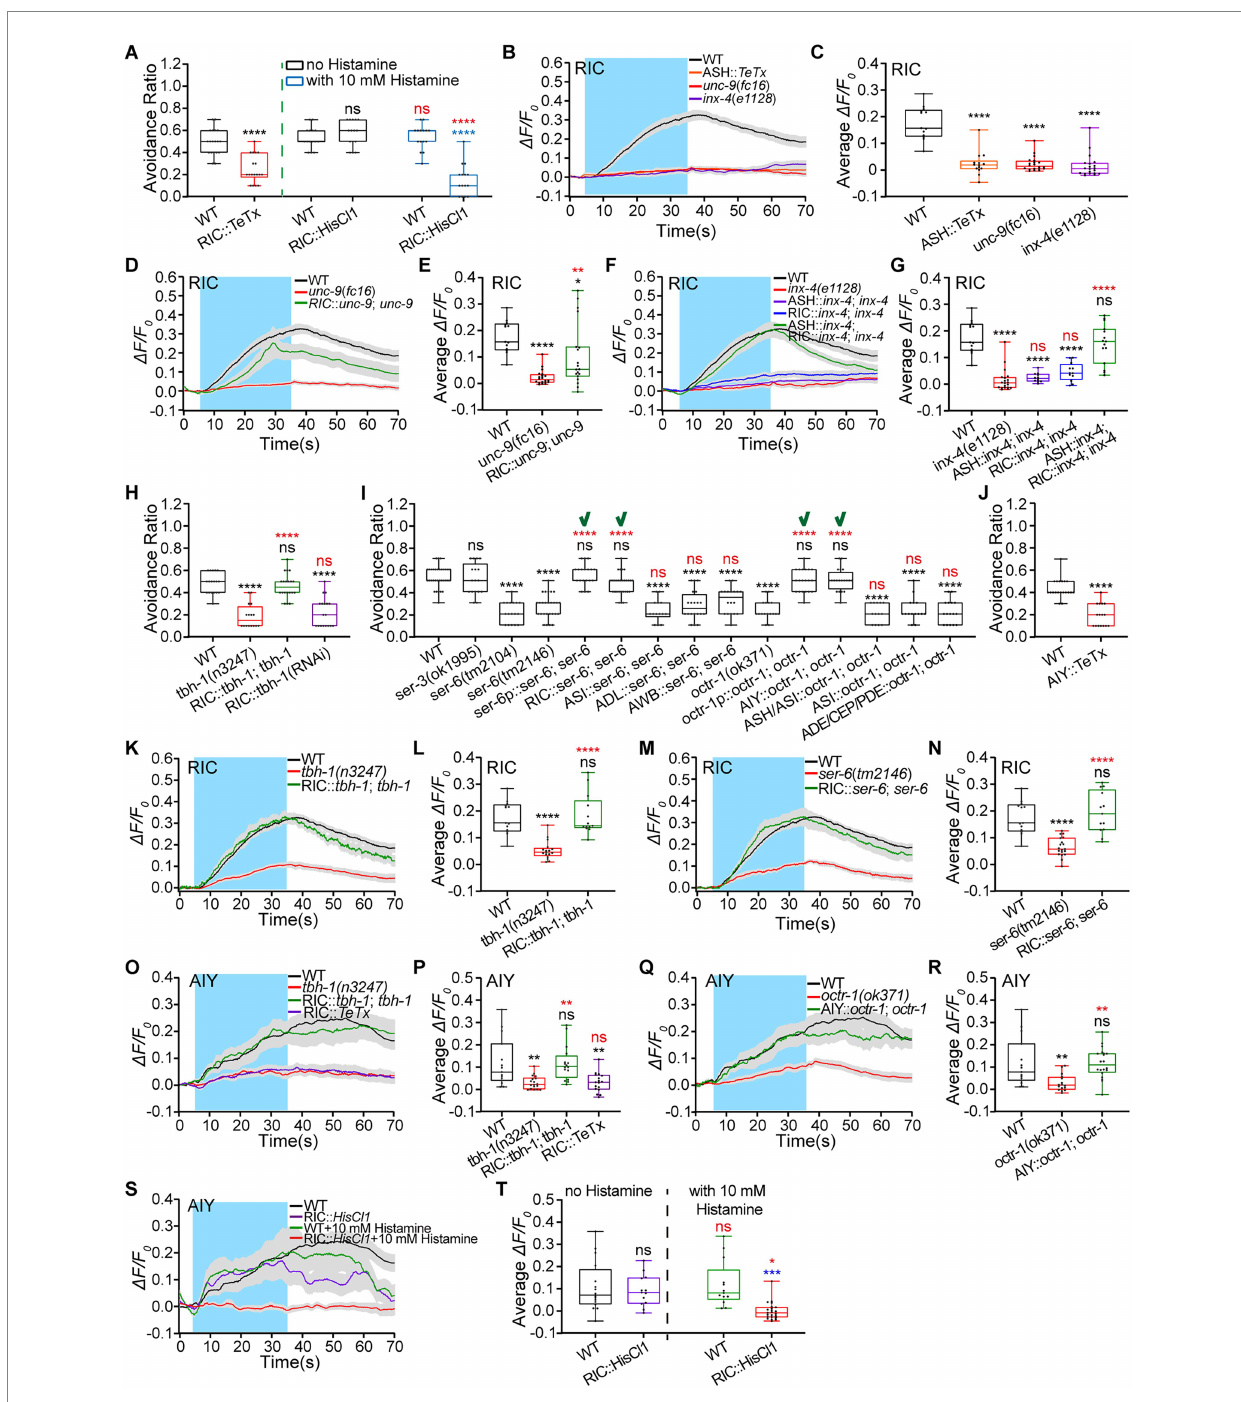
FIGURE 5 Signaling pathways of Octopamine/SER-6 in RIC and octopamine/OCTR-1 in AIY promote animals’ hyperosmotic avoidance. (A) Ratio of avoidance of the hyperosmolality of 0.88 Osm by glycerol/M13 in wild-type (WT) N2 as control and transgenic animals of indicated genotypes. (B–G) The somal calcium signals in RIC interneurons in response to the hyperosmolality of 0.88 Osm in WT, mutant, and transgenic animals of indicated genotypes. (B,D,F) Curves of Ca 2+ transients presented as means (solid traces) ± SEM (gray shading) with cerulean background indicating the application of 0.88 Osm glycerol/M13 solution; (C,E,G) box plots of the average intensity of Ca 2+ signals during stimulation with each dot representing the data from each tested animal or test. (H–J) Ratio of avoidance of the droplet of the hyperosmotic solution in WT N2, mutant, and transgenic animals of indicated genotypes. “ √ ” indicates the success of restoring WT behavior by the genetic rescue indicated. (K–T) The somal calcium signals in RIC (K–N) and AIY (O–T) interneurons in response to the hyperosmolality of 0.88 Osm in WT, mutant, and transgenic animals of indicated genotypes. (K,M,O,Q,S) Curves of Ca 2+ transients presented as means (solid traces) ± SEM (gray shading) with cerulean background indicating the application of 0.88 Osm glycerol/M13 solution; (L,N,P,R,T) box plots of the average intensity of Ca 2+ signals during stimulation with each dot representing the data from each individual tested worm. Heat maps of Ca 2+ signals are shown in Supplementary Figures S6, S7. Statistical significance is indicated as and in different colors: ns, not significant, * p < 0.05, ** p < 0.01, *** p < 0.001, and **** p < 0.0001 in different colors; black, the tested vs. the WT; red, the gene rescued vs. the related mutant, or the histamine treated vs. histamine untreated of the same genotype (in A,T ); blue, the tested vs. the WT under histamine treatment (in A,T